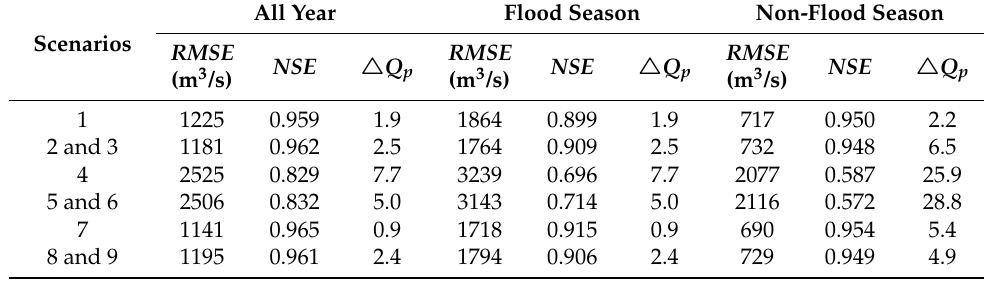
Table 3. Statistical measurements between the observed and simulated outflows.